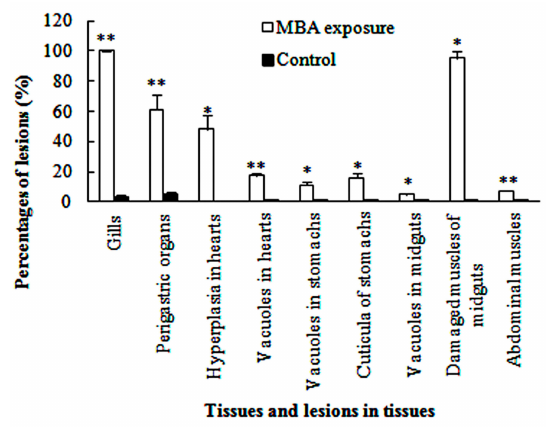
Figure 8. Percentages of the number or area of lesions in the six tissues of MBA-treated and control P. clarkii (Mean ± SE). Herein, all of the rounded and elliptical gill crosscuts, and those with one or multiple obvious lesions among these gill crosscuts were counted one by one, respectively; similar method was performed on tubules of the perigastric organs. For the hearts, stomachs, midguts and abdominal muscles, the areas of the total samples and parts with different lesions were measured, respectively, and only hyperplasia and vacuoles in the hearts, cuticula damages and vacuoles in the stomachs, and vacuoles and muscle damages in the midguts were separately analyzed for they were the main lesions in these organs. Percentages of the damaged muscles in the midguts were the ratio of the area of the muscles with lesions to all the muscles. Asterisks represent significant differences (* p < 0.05, ** p <